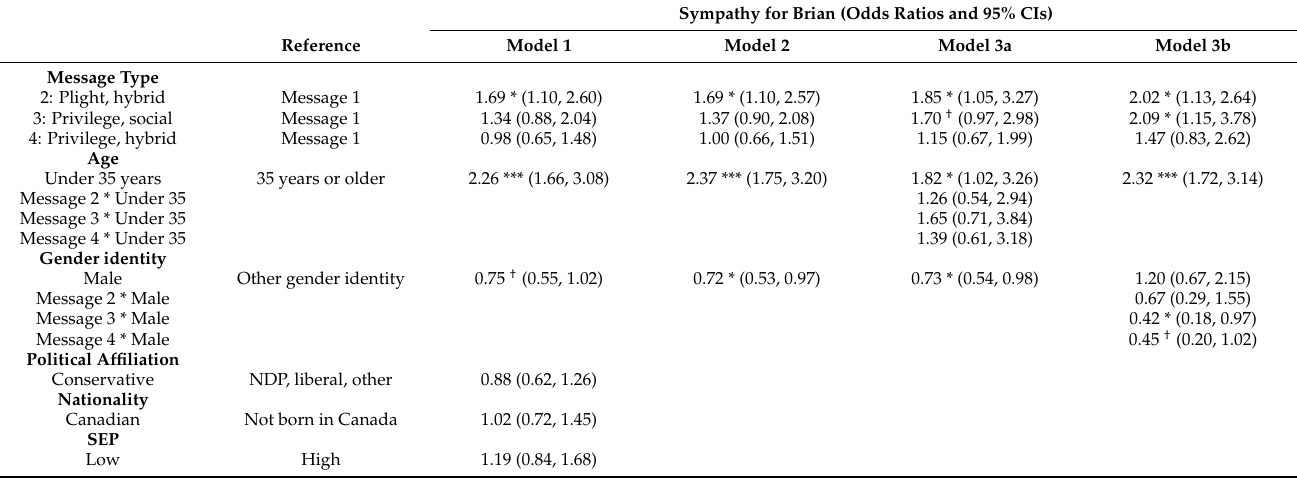
Table 5. Logistic Regression Models, predictors of sympathy for